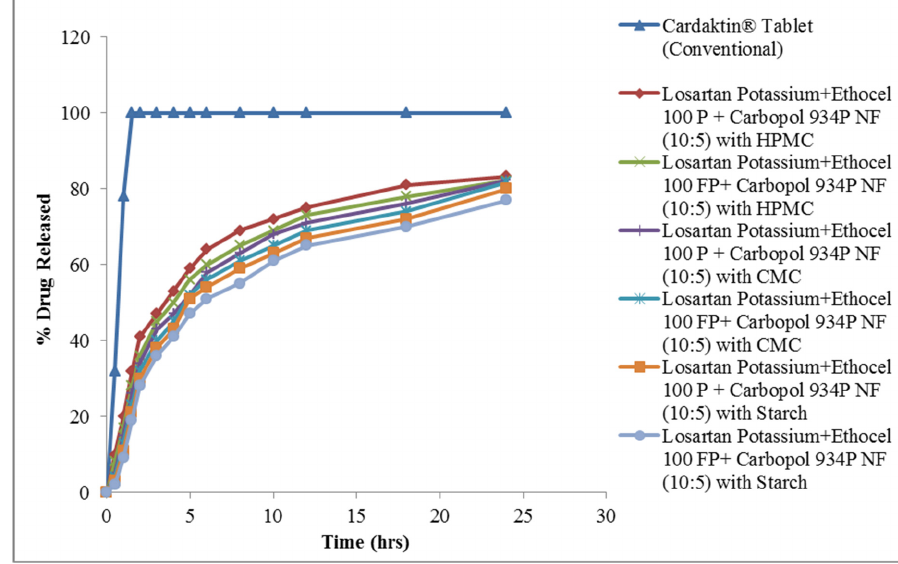
Figure 2. Drug release from polymeric matrices with co-excipients.